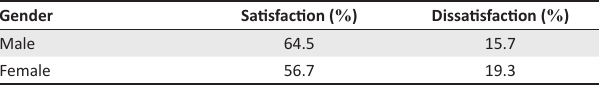
TABLE 2: Gender and satisfaction level. Gender